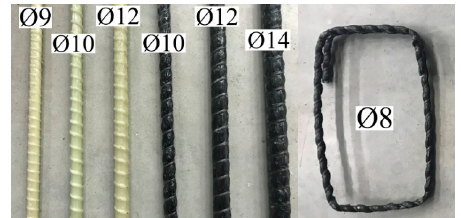
Figure 2. GFRP longitudinal and transverse bars (dimensions in mm). Table 2. Mechanical and deformation properties of GFRP bars.